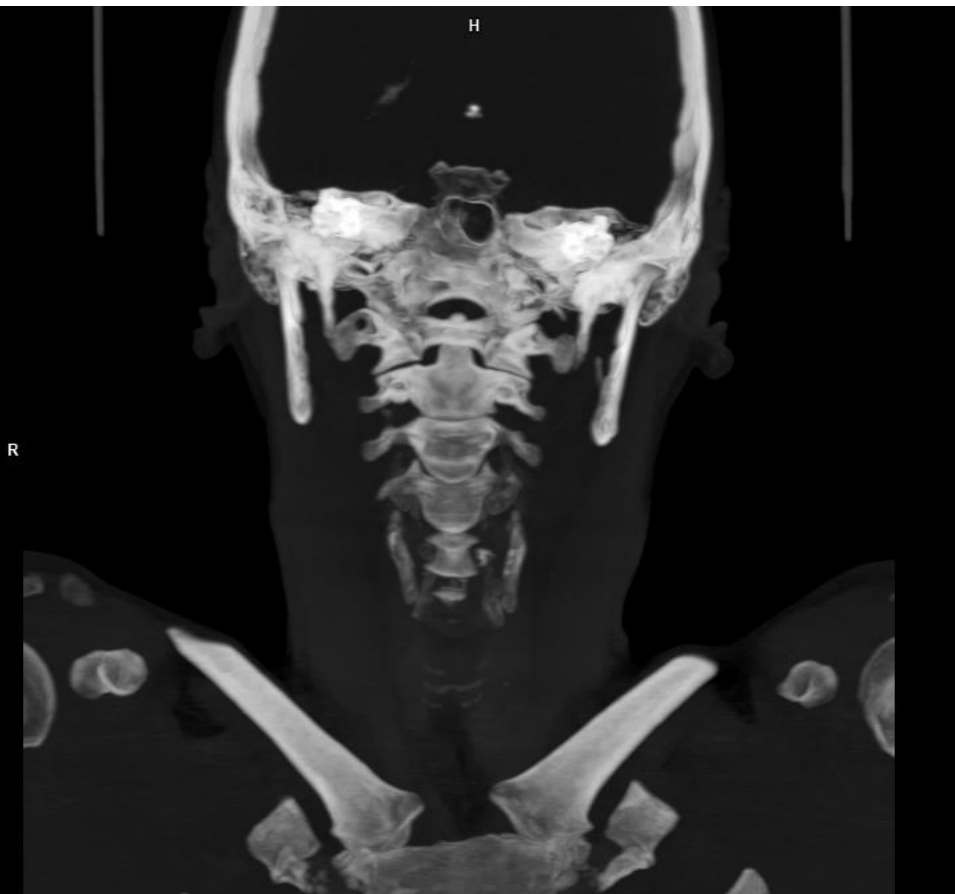
Figure 4. The styloid processes visualized on the CTA of the neck. The styloid processes length was in the normal range (15 mm bilaterally). in the normal range (15 mm